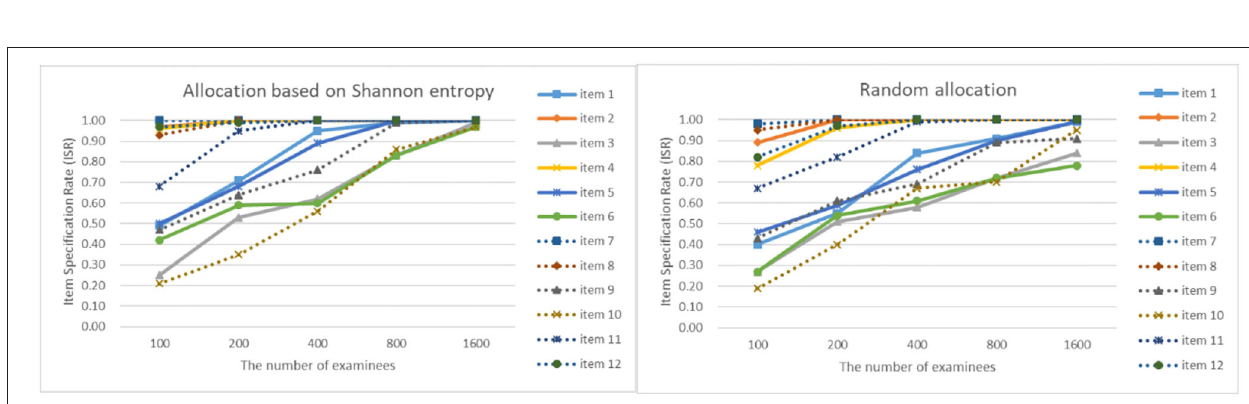
impact of different item parameters on the Q-matrix